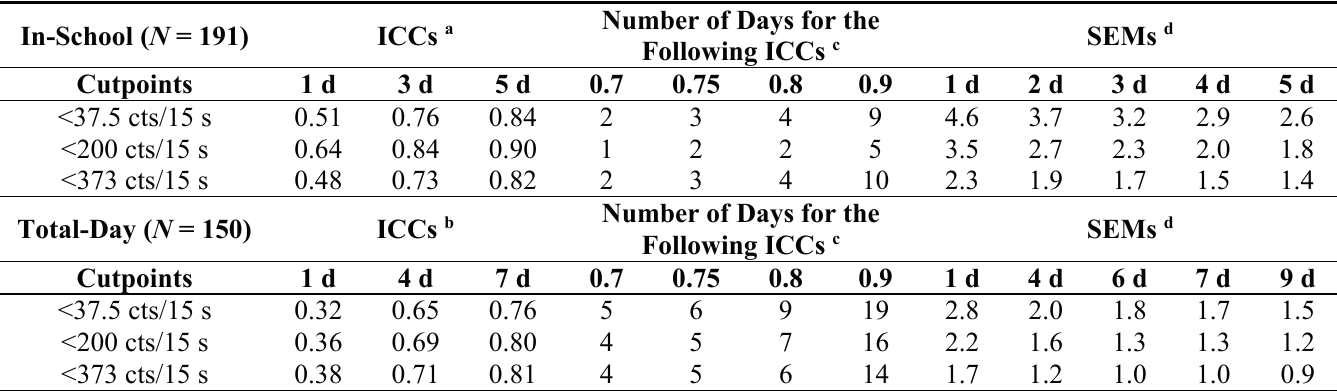
Table 4. ICCs, Number of Days to Achieve Desired ICCs, and SEMs According to Three Different